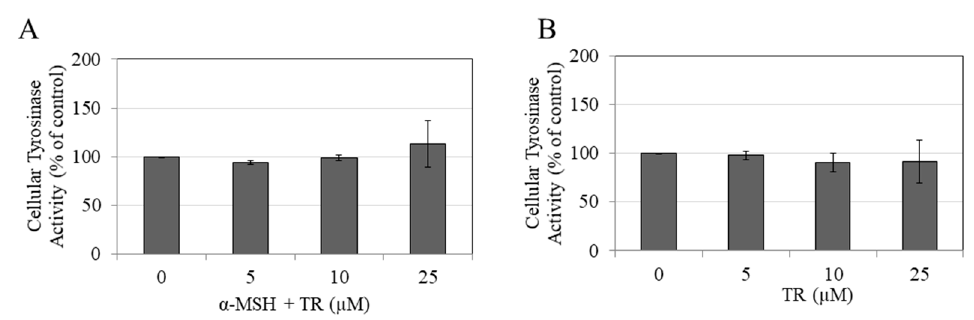
Figure 3. Tyrosinase activity in cellular lysates of B16F10 cells in the presence of different concentrations of TR for 72 h under ( A ) α -MSH stimulated and ( B ) Basal conditions; Data is Mean ± SD of at least three independent experiments.